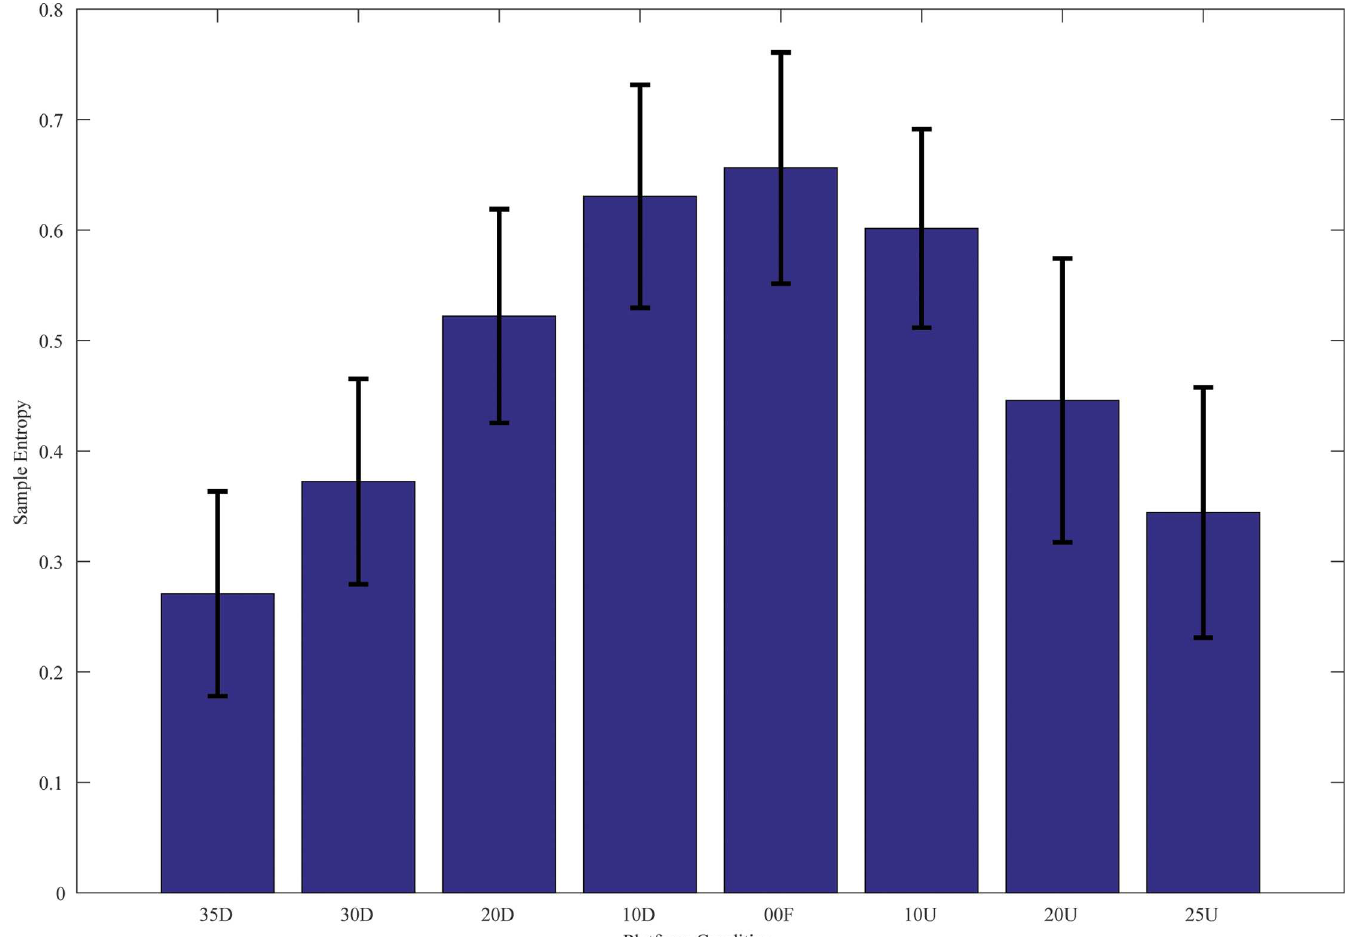
Fig 4. Group mean (n = 17) for SampEn with between-S standard deviation across all sloped platform